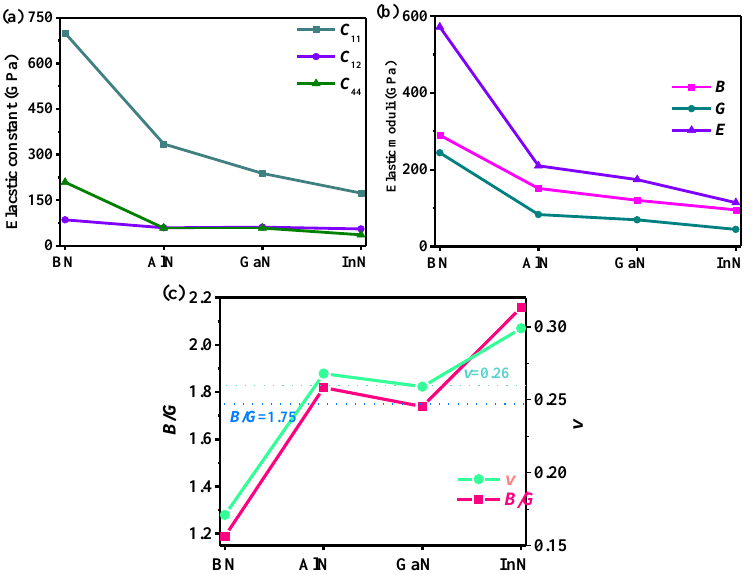
Figure 3. The elastic parameters ( a ) and B , G and E ( b ) of Pm −3 n XN and B / G and v of Pm −3 n XN ( c ). Table 2. The v s , v p , v m (m/s), and Θ D (K) of XN in the Pm −3 n , Pnma and F − 43 m phases.